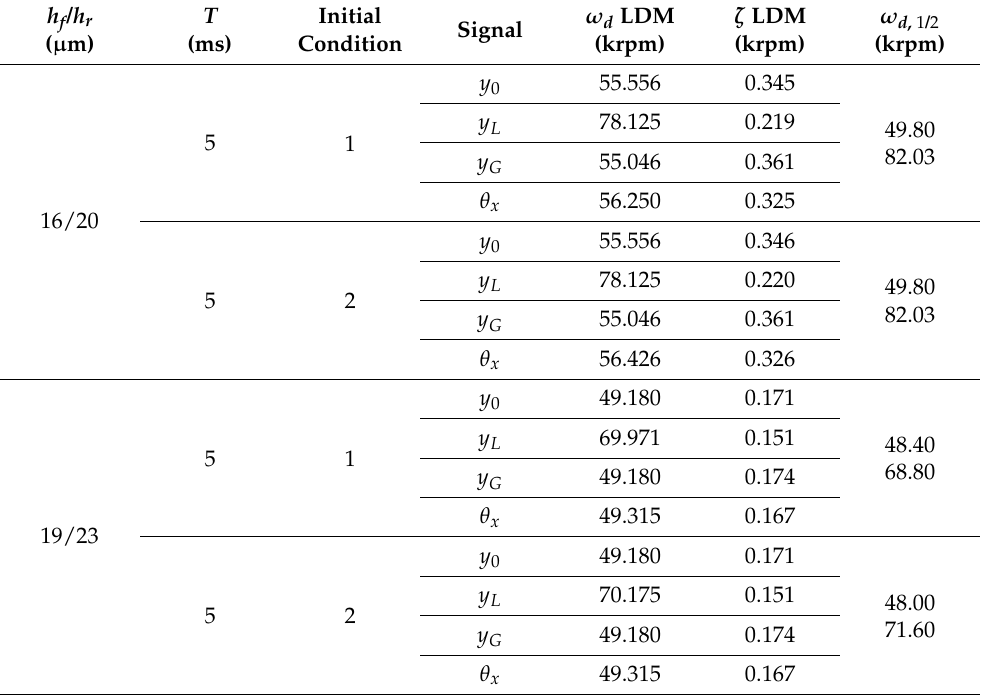
Table A1. Damped frequencies and damping factors resulting from FFT analysis and from LDM; p s = 0.3